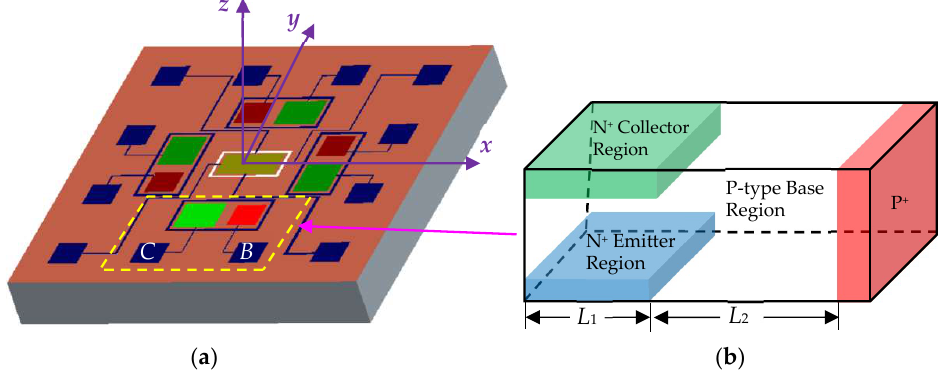
Figure 1. The basic structure diagrams of the device. ( a ) The magnetic field sensor; ( b ) equivalent structure diagram of